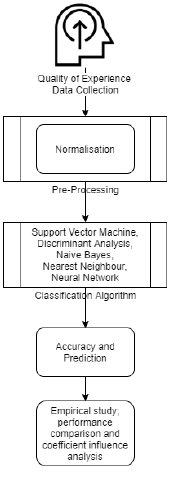
Figure 9. Data analysis. Table 8. Comparing classification metrics across all